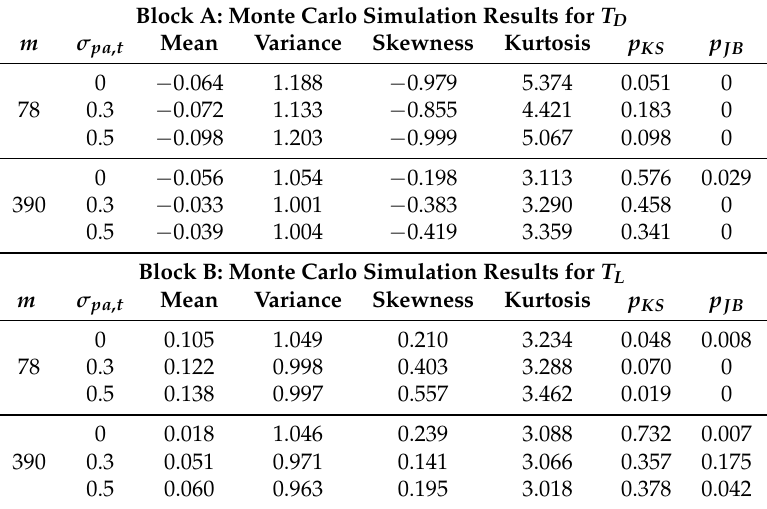
Table 1. Sample moments and p -values of Kolmogorov–Smirnov and Jarque–Bera tests for normality. Block A: Monte Carlo Simulation Results for T D m σ pa , t Mean Variance